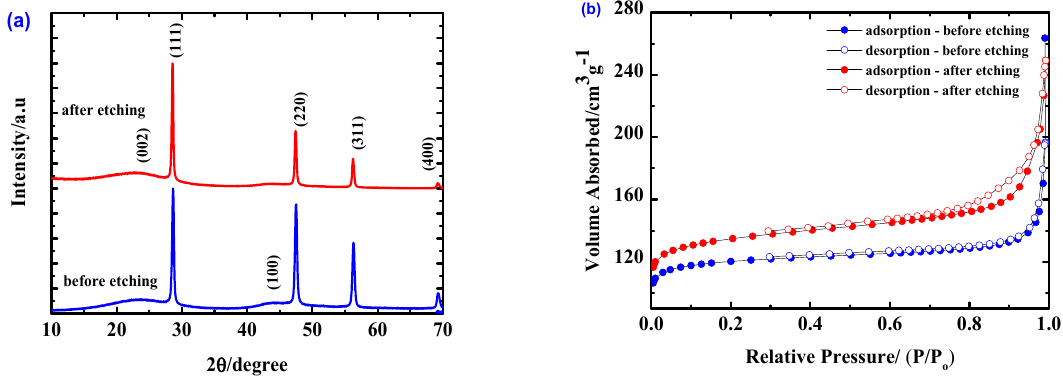
Figure 1. ( a ) XRD patterns and ( b ) N 2 adsorption/desorption isotherms of Si/MC composites before and after etching. Table 2. Surface and porous parameters of Si/MC composites.